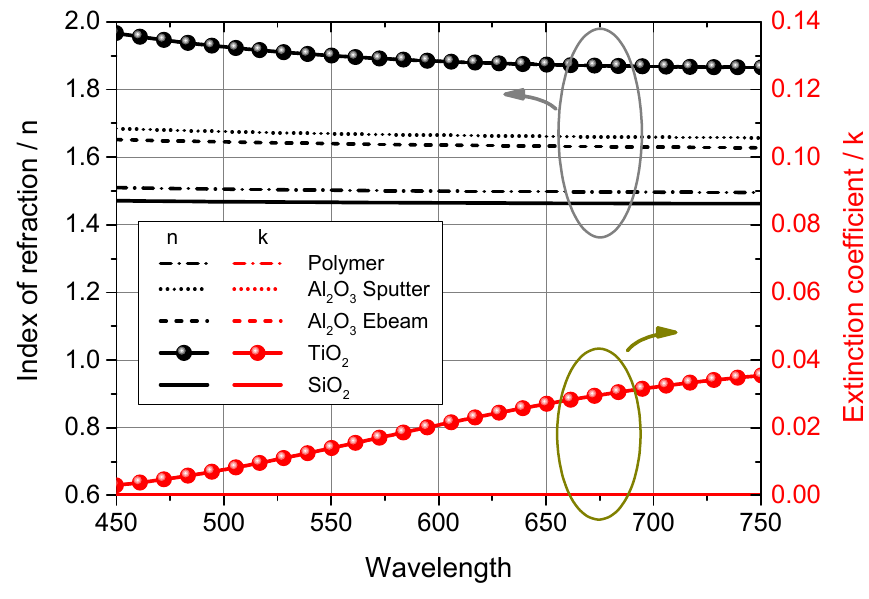
Figure 5. The optical constants n and k for the used DBR materials and the